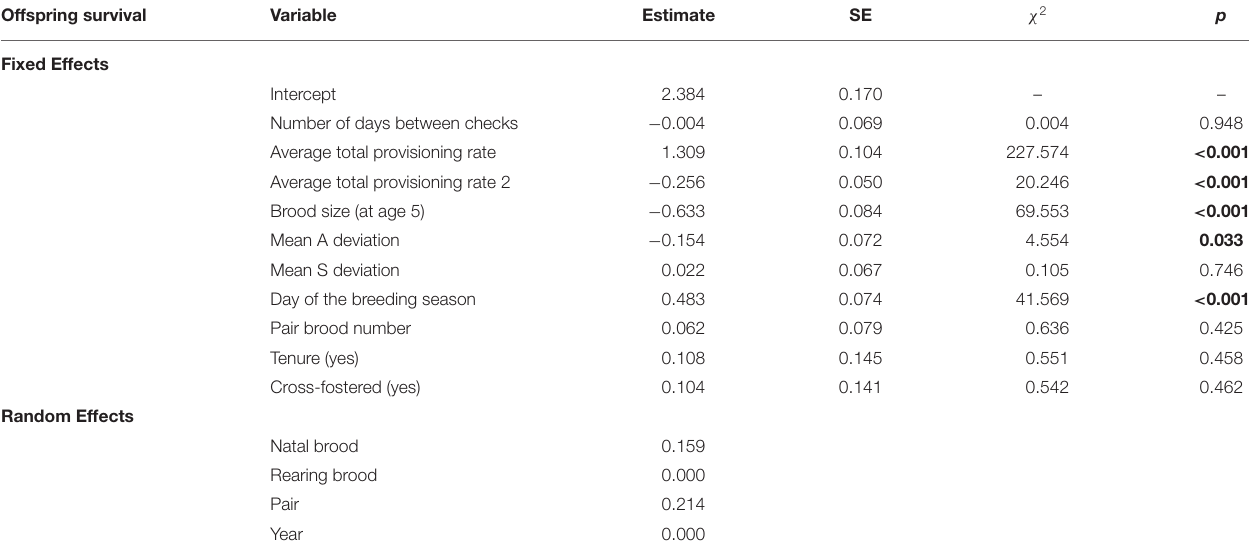
TABLE 1 | Model estimates and standard errors (SE) for each of the predictors of offspring survival to fledging ( N = 2,482 offspring alive at age 5, 2,112 survived to ringing). Offspring